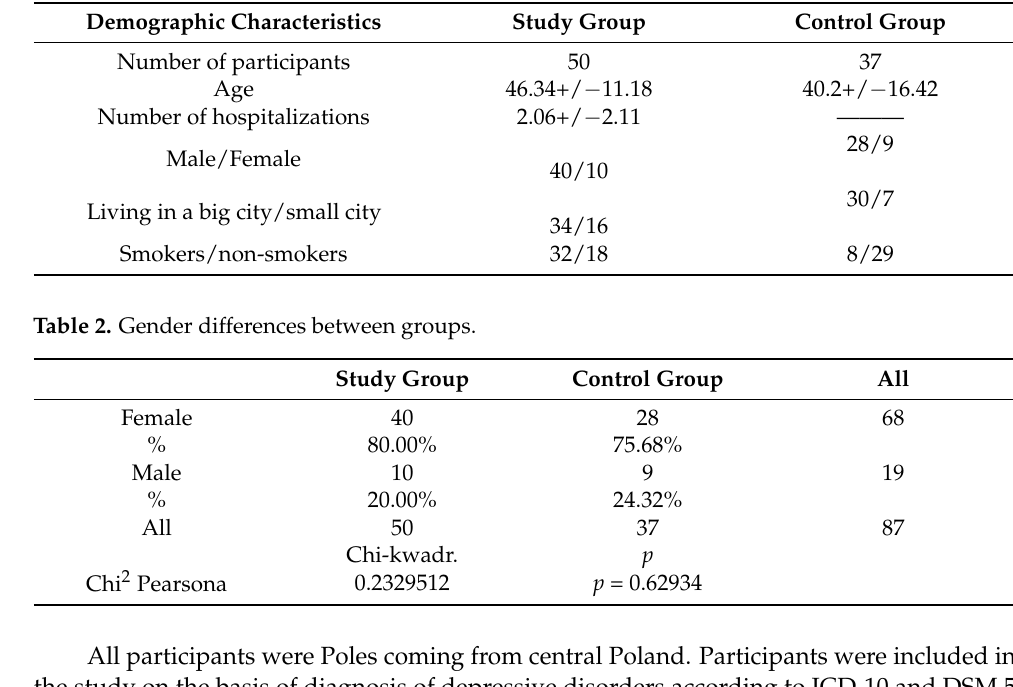
Table 1. Demographic characteristics of study group and control group. Parameters associated with severity of depression.